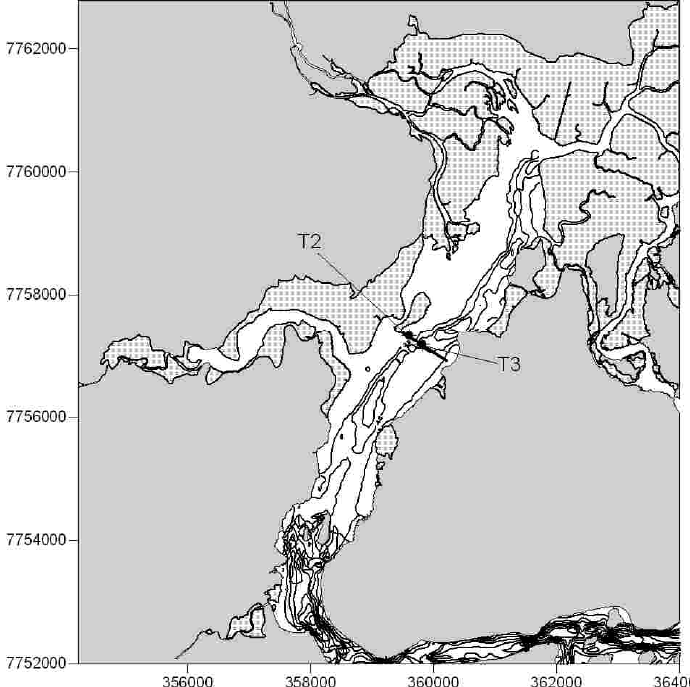
Fig. 3 – Core locations in relation to the present bottom morphology.